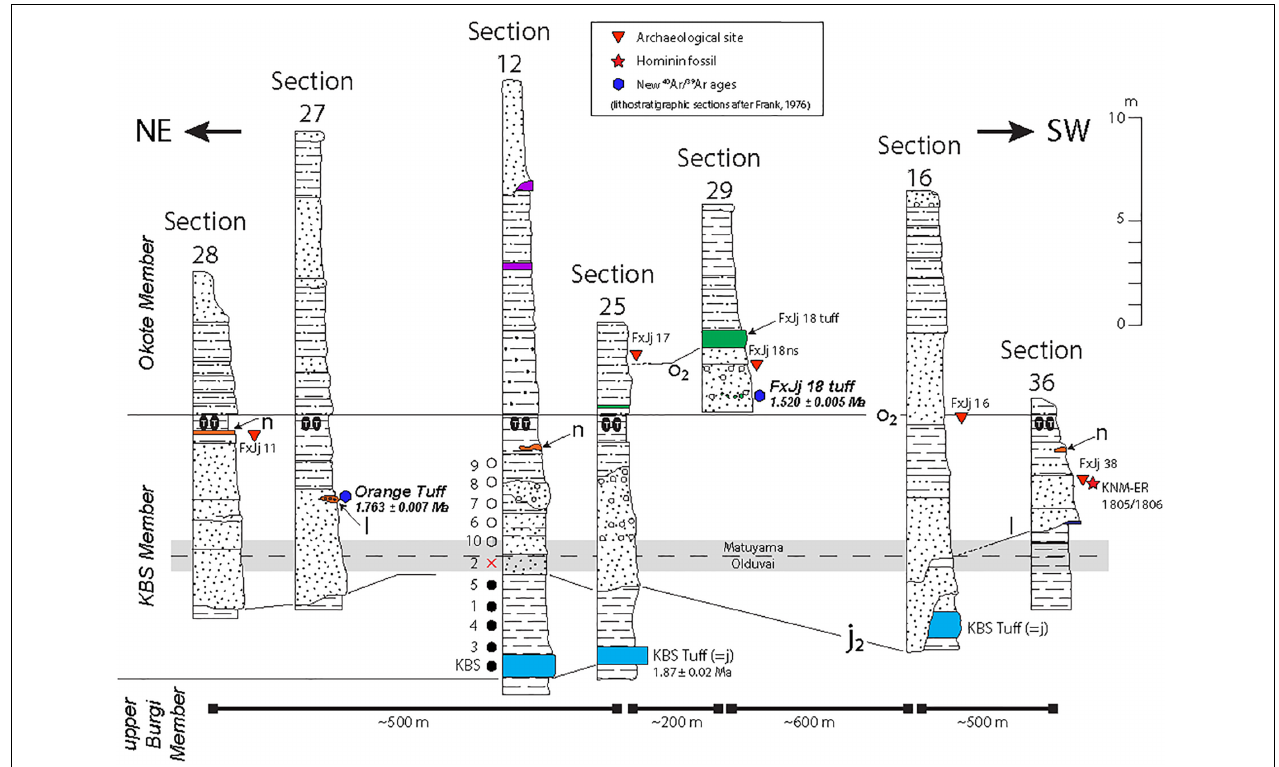
FIGURE 3 | Lithostratigraphic sections modified from Frank (1976). Map view location can be found in Figure 2 . Lithological symbols are as follows: open circles = conglomerate, black dots = sandstone, horizontal lines and/or horizontal lines with black dots = mudstone (more/less dots denote coarseness/fineness of the mudstone, ranging from silty claystone to sandy siltstone), black ovals with white Ts indicate well-developed paleosol horizon with carbonate nodules. Purple levels are unnamed tuffs in the study area. Green level is the tuff at archeological site FxJj 18 complex; note green pumices in underlying conglomerates. Along lateral exposure (not depicted) the FxJj 18 tuff merges with the underlying conglomerates and the pumice clasts, which were dated, can be found within the tuff at outcrops exposed between sections 25 and 29. Orange levels are the Orange Tuff where level “n” is fine-grained, while “l” is coarser. Blue levels represent the KBS Tuff. Ages for the Orange Tuff and the FxJj18 Tuff are from this study, age for the KBS Tuff from McDougall and Brown (2006), age for the KBS-Okote boundary from Brown et al. (2006). See section “Review of the Area 130 Stratigraphy” in text for information on alphanumeric mapping units (i.e., j , j 2 , l , n , and o 2 ) from Frank (1976). Symbols along lower part of section 12 are interpreted paleomagnetic data (numbers match sample analyses reported in Table 1 ; filled black circles are normal polarity, open circles are reverse polarity, and open circle with gray shading indicates reverse polarity with an intermediate declination direction). Red cross symbol represents a sample with a MAD value > 15 ◦ and large normal polarity overprint, but has a thermal demagnetization trajectory that clearly bypasses the origin to reveal a reverse polarity direction (see Figure 4 for more detail and orthogonal plots). Additionally we include an estimate location for the Olduvai-Matuyama